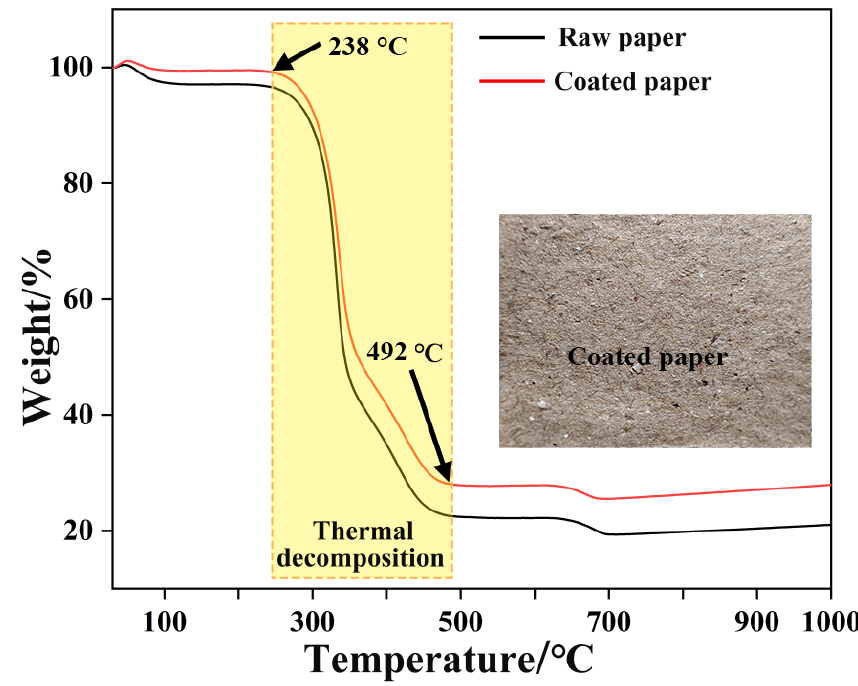
Figure 5. Thermogravimetric chart.